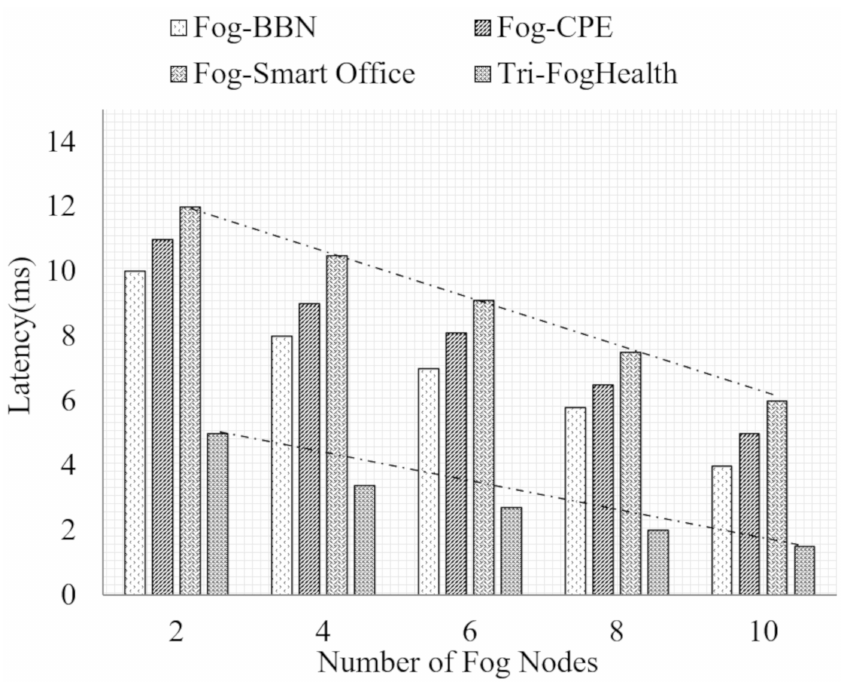
Figure 9. Comparison of Latency upon Number of Fog